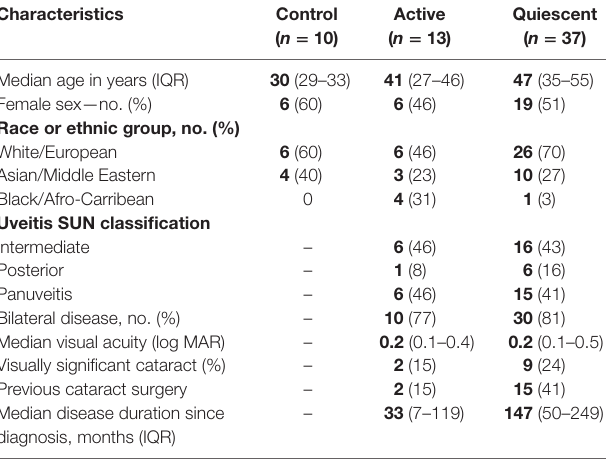
TaBle 1 | Subject demographics and clinical